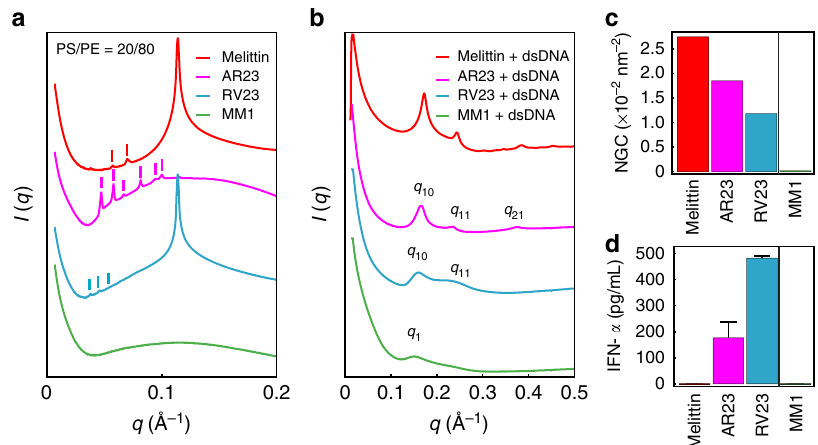
Fig. 6 Systematic reduction of the membrane activity of melittin in peptides with conserved double-stranded DNA (dsDNA)-binding activity corresponds with a recovery of TLR9-activating ability. a Small-angle X-ray scattering (SAXS) spectra from PS/PE = 20/80 model membranes incubated with melittin, AR23, RV23, and MM1 at P / L = 1/2. Melittin, AR23, and RV23 induce Pn3m cubic phases in model membranes, while MM1 does not induce appreciable changes compared to controls (Supplementary Figure 7). Correlation peaks corresponding to assigned re fl ections for the Pn3m cubic phases are labeled for melittin, AR23, and RV23. b SAXS spectra corresponding to the structures of melittin-, AR23-, RV23-, and MM1-DNA complexes. The melittin-DNA SAXS data are reproduced here from Fig. 1 for ease of comparison. Higher-order re fl ections for the AR23 and RV23 square lattices are labeled. AR23 and RV23 form square columnar lattices with dsDNA (similar to melittin and LL37), while MM1 forms a disordered columnar arrangement. c The absolute value of average negative Gaussian curvature (NGC) is calculated from the lattice parameter ( a ) of the cubic phases measured in a . Compared to melittin, AR23 and RV23 induce decreasing amounts of NGC in membranes, while MM1 does not induce NGC at all. d Measured TLR9-speci fi c interferon (IFN)- ɑ production (pg mL − 1 ) from human pDCs induced by AMP-dsDNA complexes. Systematic reduction of NGC-inducing ability in melittin-related peptides AR23 and RV23 ( b ) correlate with a recovery in ability to induce IFN- ɑ from pDCs. MM1 is unable to induce NGC or IFN- ɑ production from pDCs. Error bars denote